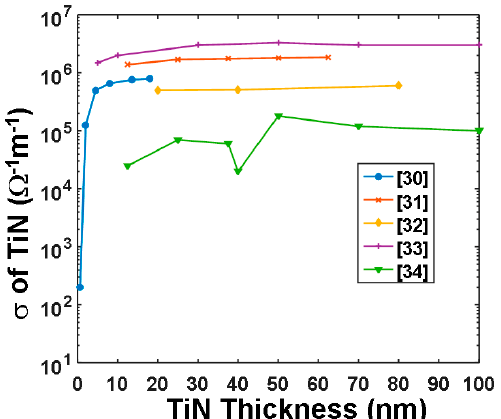
Figure 9. The electrical conductivity of TiN films with respect to its thickness for different deposition techniques.